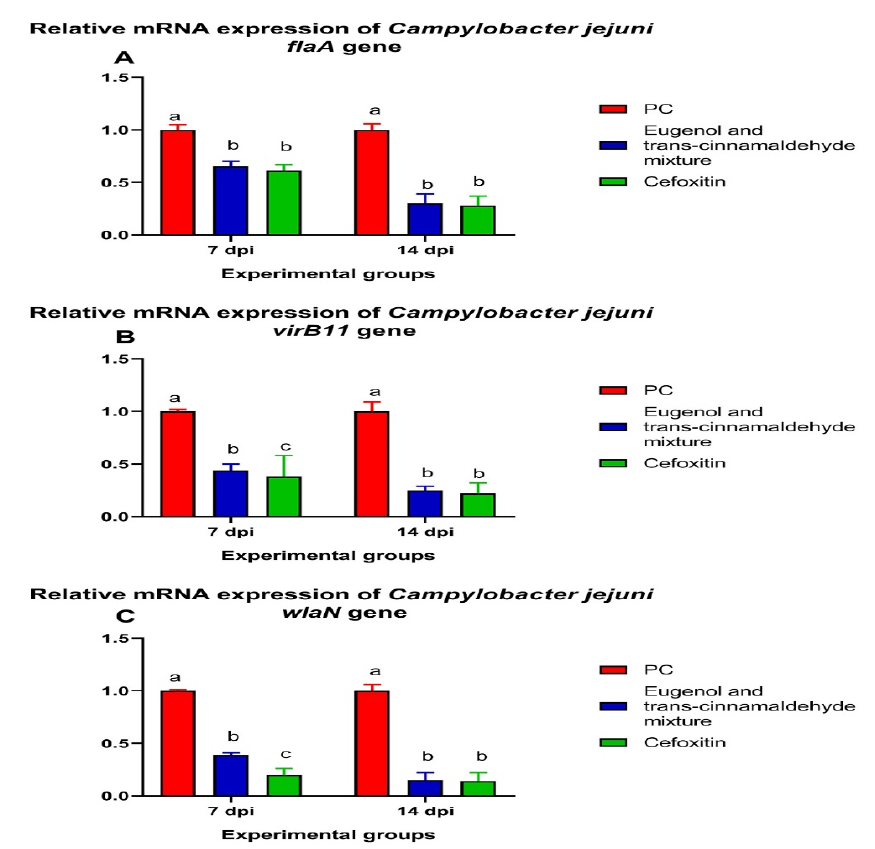
Figure 6. Relative mRNA expression levels of the C. jejuni flaA ( A ) , virB11 ( B ), and wlaN ( C ) genes in response to supplementing the mixture of eugenol and trans-cinnamaldehyde and treatment with cefoxitin antibiotic at 7 and 14 days post-infection (dpi) with XDR C. jejuni , as were determined via the RT-qPCR assay. The results are expressed as the means ± standard error of the mean (SEM, error bars). PC (positive control): chicks fed a basal diet and challenged with XDR C. jejuni ; eugenol and trans-cinnamaldehyde mixture: chicks fed a basal diet supplemented with a mixture of eugenol and trans-cinnamaldehyde; and cefoxitin: chicks fed a basal diet and treated with cefoxitin antibiotic. All the groups, except the NC group, were challenged with XDR C. jejuni at 23 days of age. a–c Means of the columns with different letters indicate a statistically significant difference ( p <